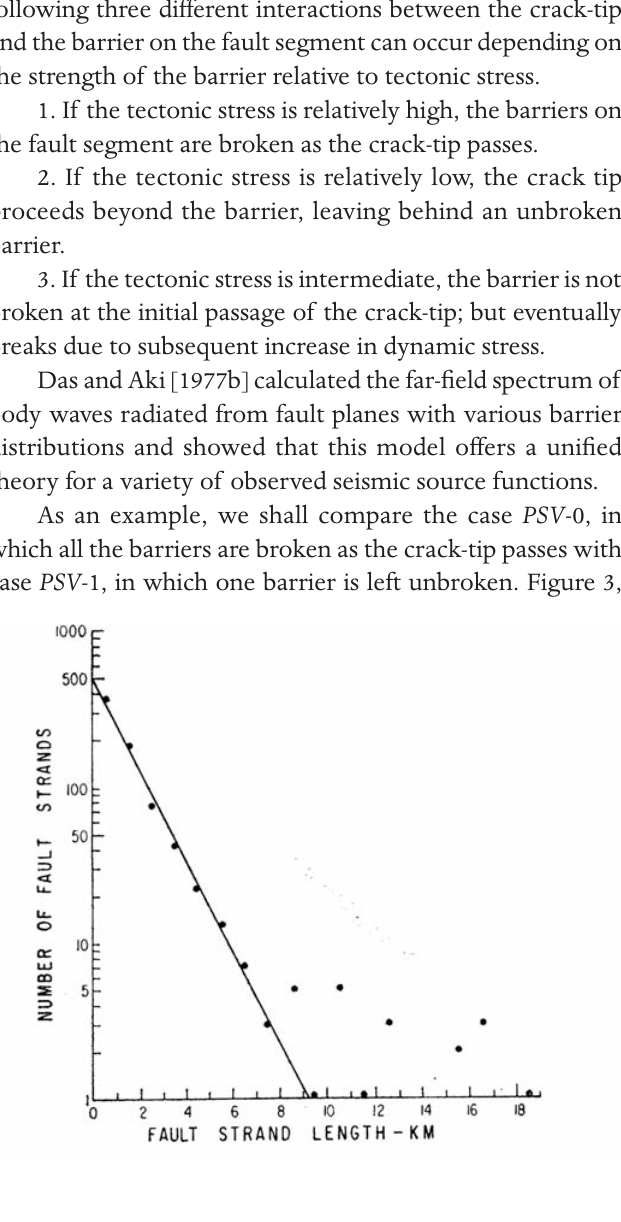
Figure 7. Frequency distribution of the length of fault strands along the San Andreas fault. Reproduced from Wallace